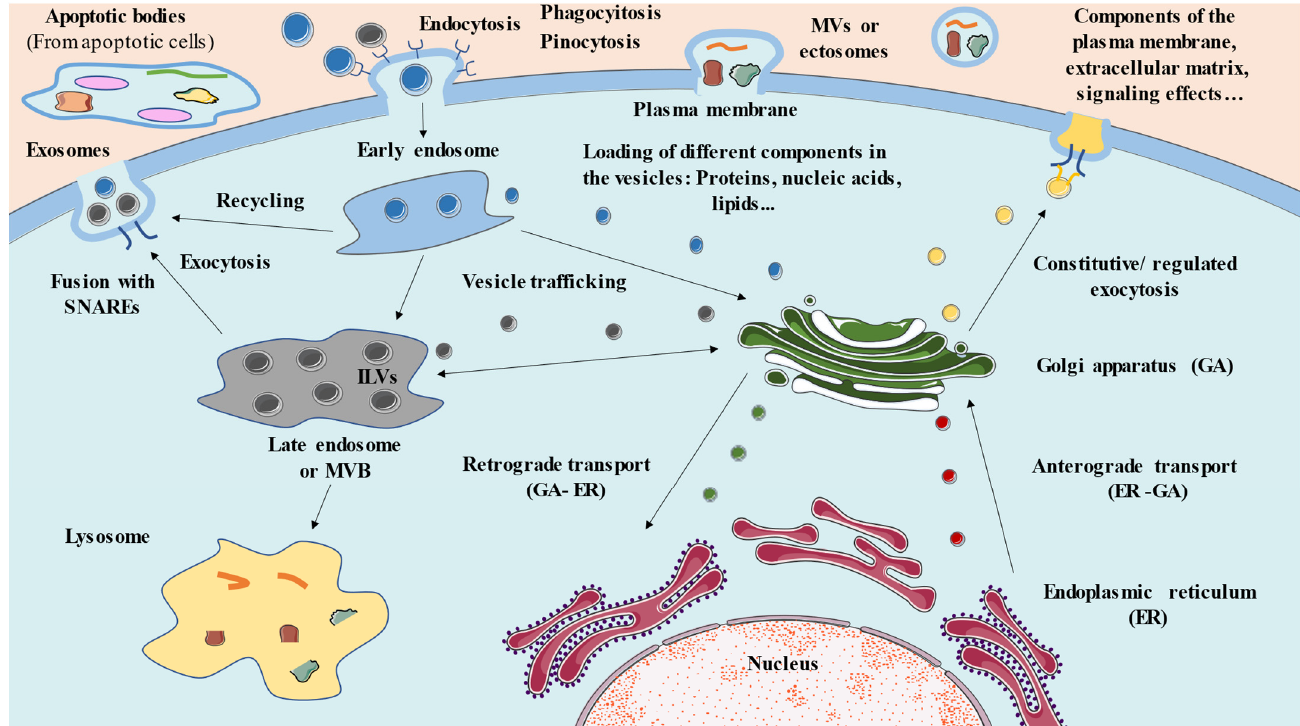
Figure 1. Summary of the main parties involved in cellular and vesicular traffic. There is communica- tion between the ER and the GA, where the vesicles are packed and classified, transporting different contents in both directions (anterograde and retrograde transport). Some of these vesicles are sent to the plasma membrane to be secreted by a process of constitutive or regulated exocytosis (mainly me- diated by the SNARE complex). By endocytosis, different vesicles and substances from the medium are captured, entering the cell and forming the early endosome. The early endosome can recycle these components back to the cell exterior, send them to the GA, or give rise to a secondary endosome, also called multivesicular bodies (MVBs), as this structure contains multiple smaller vesicles known as intraluminal vesicles (ILVs). There is important communication between the GA and MVBs, yielding a bidirectional exchange of vesicles that can be secreted, giving rise to exosomes or becoming part of lysosomes for their subsequent degradation. Likewise, other types of extracellular vesicles,